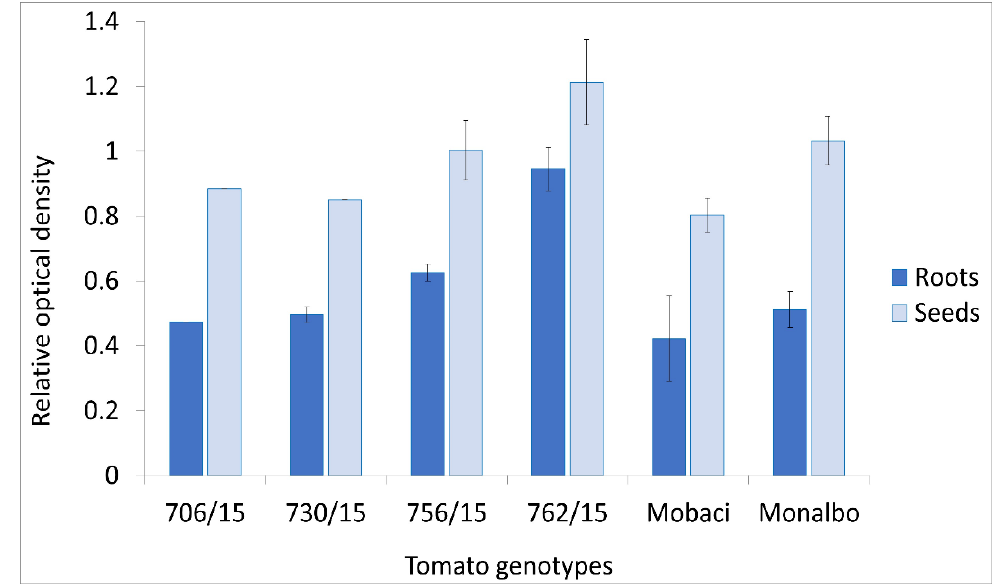
Figure 7. Detection of ToMV SL-1 in roots and seeds of infected tomatoes using the AB-1 antibody (mean values and standard deviation error bars).